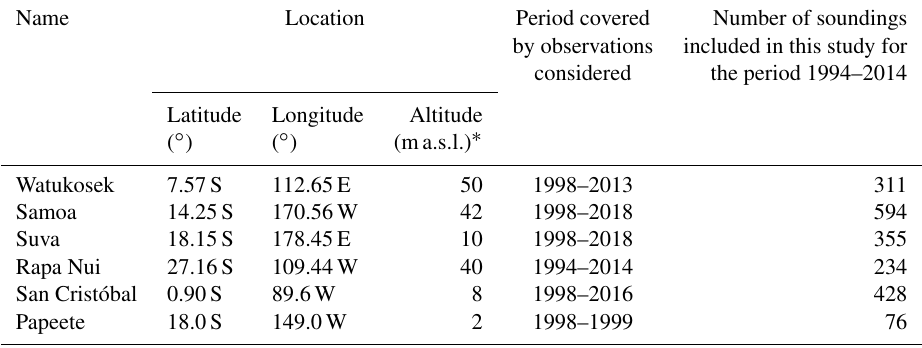
Table 1. Ozone sounding stations in the Pacific Ocean considered in this study. Data were obtained from Southern Hemisphere ADditional OZonesondes (SHADOZ, https://tropo.gsfc.nasa.gov/shadoz/, last access: 4 December 2018) and from Rapa Nui from https://www.cr2.cl/ datos-ozonosonda/ (last access: 23 March 2018). Name Location Period covered Number of soundings by observations included in this study for considered the period 1994–2014 Latitude Longitude Altitude ( ◦ ) ( ◦ ) (ma.s.l.) ∗ Watukosek 112.65E